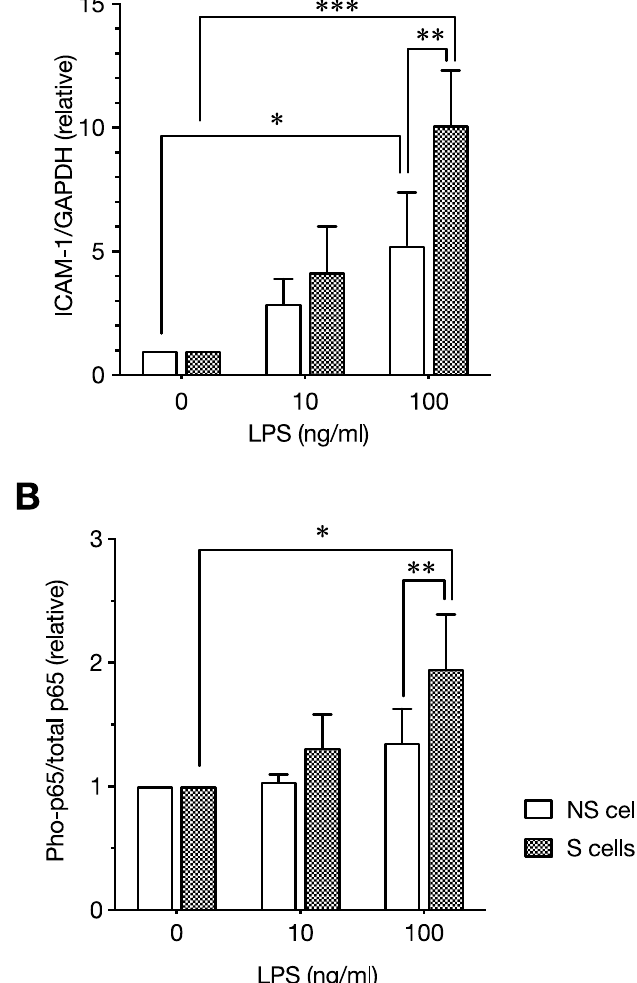
Figure 3. A comparison of the levels of lipopolysaccharide (LPS)-induced ICAM-1 expression and NF- κ B p65 phosphorylation in senescent and non-senescent endothelial cells. Senescent and non- senescent human umbilical vein endothelial cells (HUVECs) were incubated with or without LPS (10 or 100 ng/mL) for 24 h, and the expression of ICAM-1, p65, and phosphorylated p65 (Pho-p65) was analyzed by Western blotting. The relative expression of ICAM-1:GAPDH ( A ) and Pho-p65:total p65 ( B ) was expressed as a ratio to control cells (0) incubated without LPS in senescent (S) and non-senescent (NS) cells. Data are the mean ± standard deviation (SD) of four independent experiments. Values were compared with (100 ng/mL) and without (0 ng/mL) LPS incubation, as well as between senescent and non-senescent cells incubated with LPS (100 ng/mL). LPS-induced ICAM-1 expression and Pho-p65 level were enhanced in senescent cells. * p < 0.05, ** p < 0.01, and *** p < 0.001 [93]. Interestingly, it has been reported that TNF- α can induce endothelial senescence [12]. Moreover, angiotensin II and TGF- β induce vascular smooth muscle cell senescence [102,103]. Thus, it may be possible that LPS enhances the SASP-associated responses of senescent endothelial cells and smooth muscle